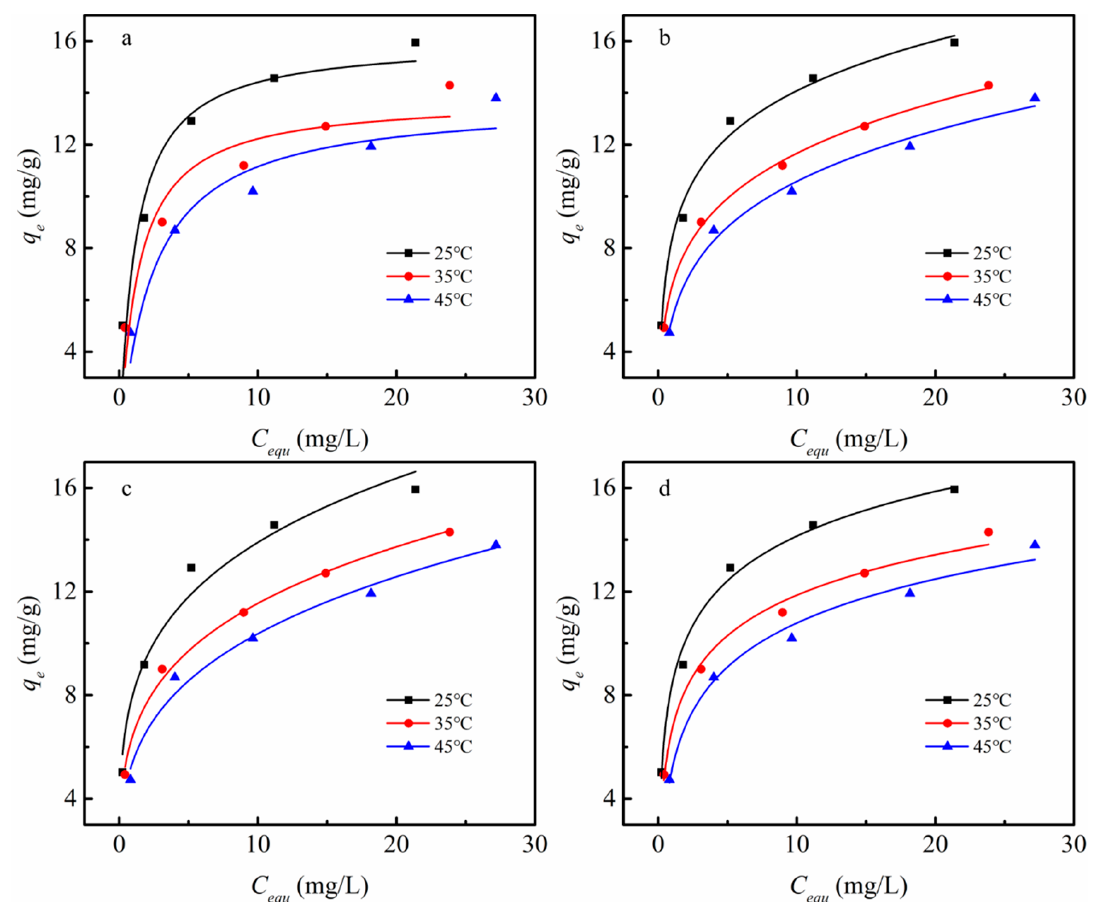
Figure 5. Adsorption isotherms of ( a ) Langmuir model, ( b ) Freundlich model, ( c ) Redlich-Peterson model, and ( d ) Temkin model for methylene blue adsorption by Fe 3 O 4 @C nanoparticles. (Time: 1 h, initial pH: 7.0, the adsorbent dosage of 2.0 g/L). Table 3. Parameters of the Langmuir and Freundlich adsorption isotherm models for MB adsorbed on Fe 3 O 4 @C nanopar- ticles. Temp .